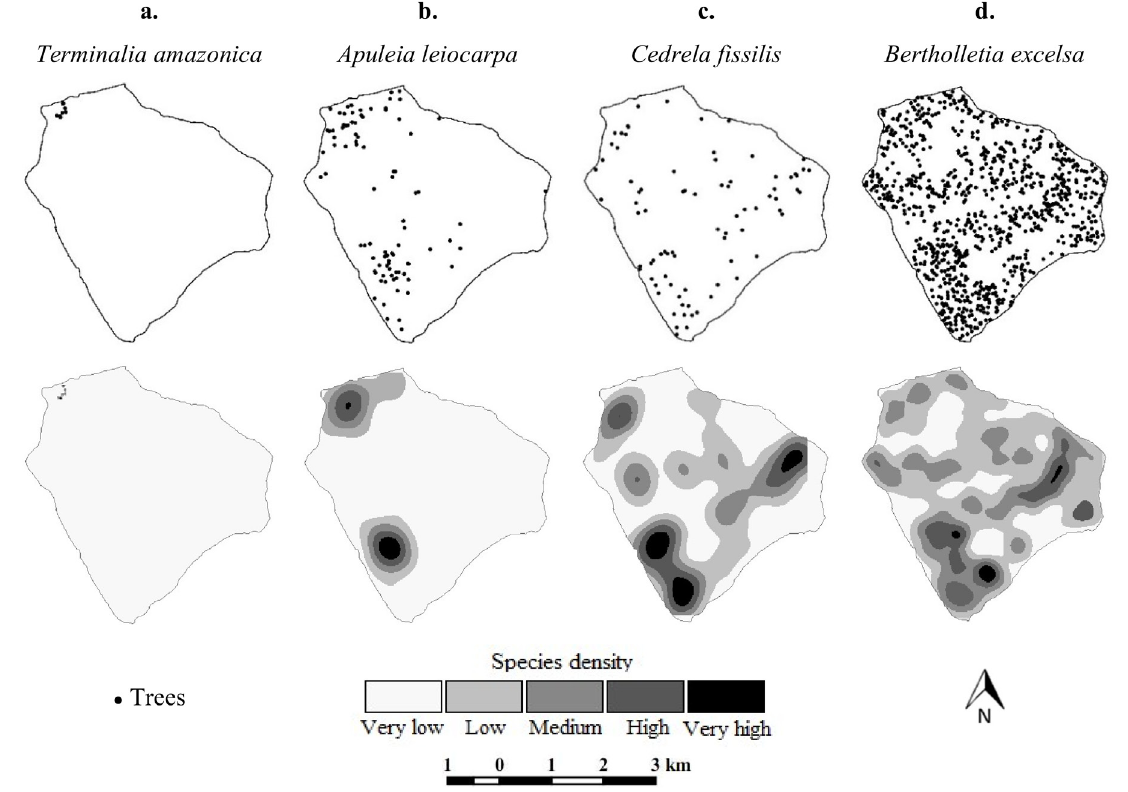
Figure 2 - Spatial distribution of the commercial tree species in Jamari National Forest, Brazilian